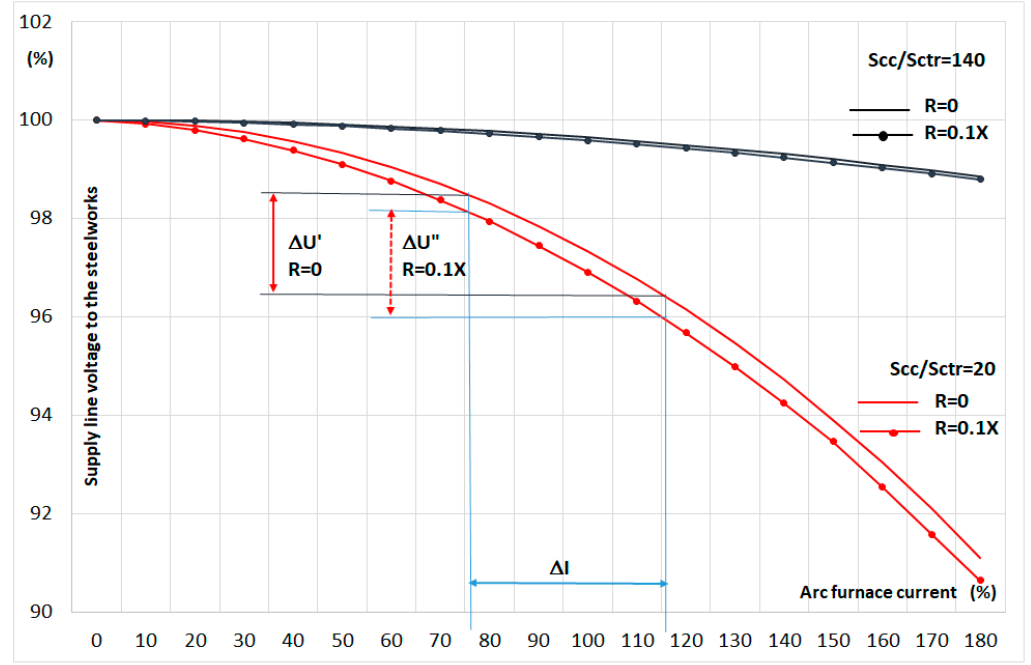
Figure 10. Voltage changes in the steel network supplying the electrodes with the charge short circuit.